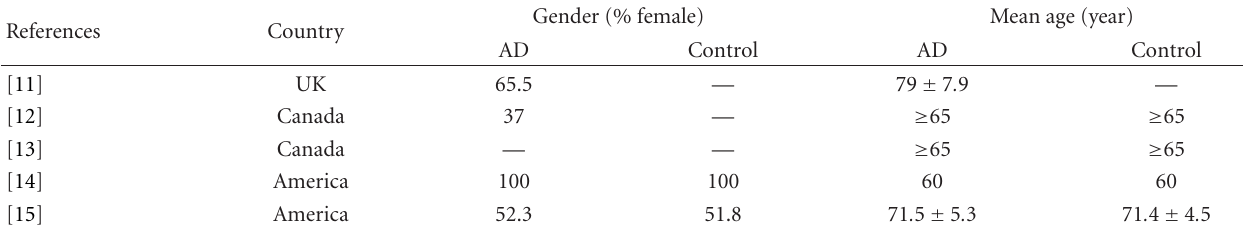
Table 3: Country, gender, and mean age of the references included in the meta-analysis of AD and hip fracture.